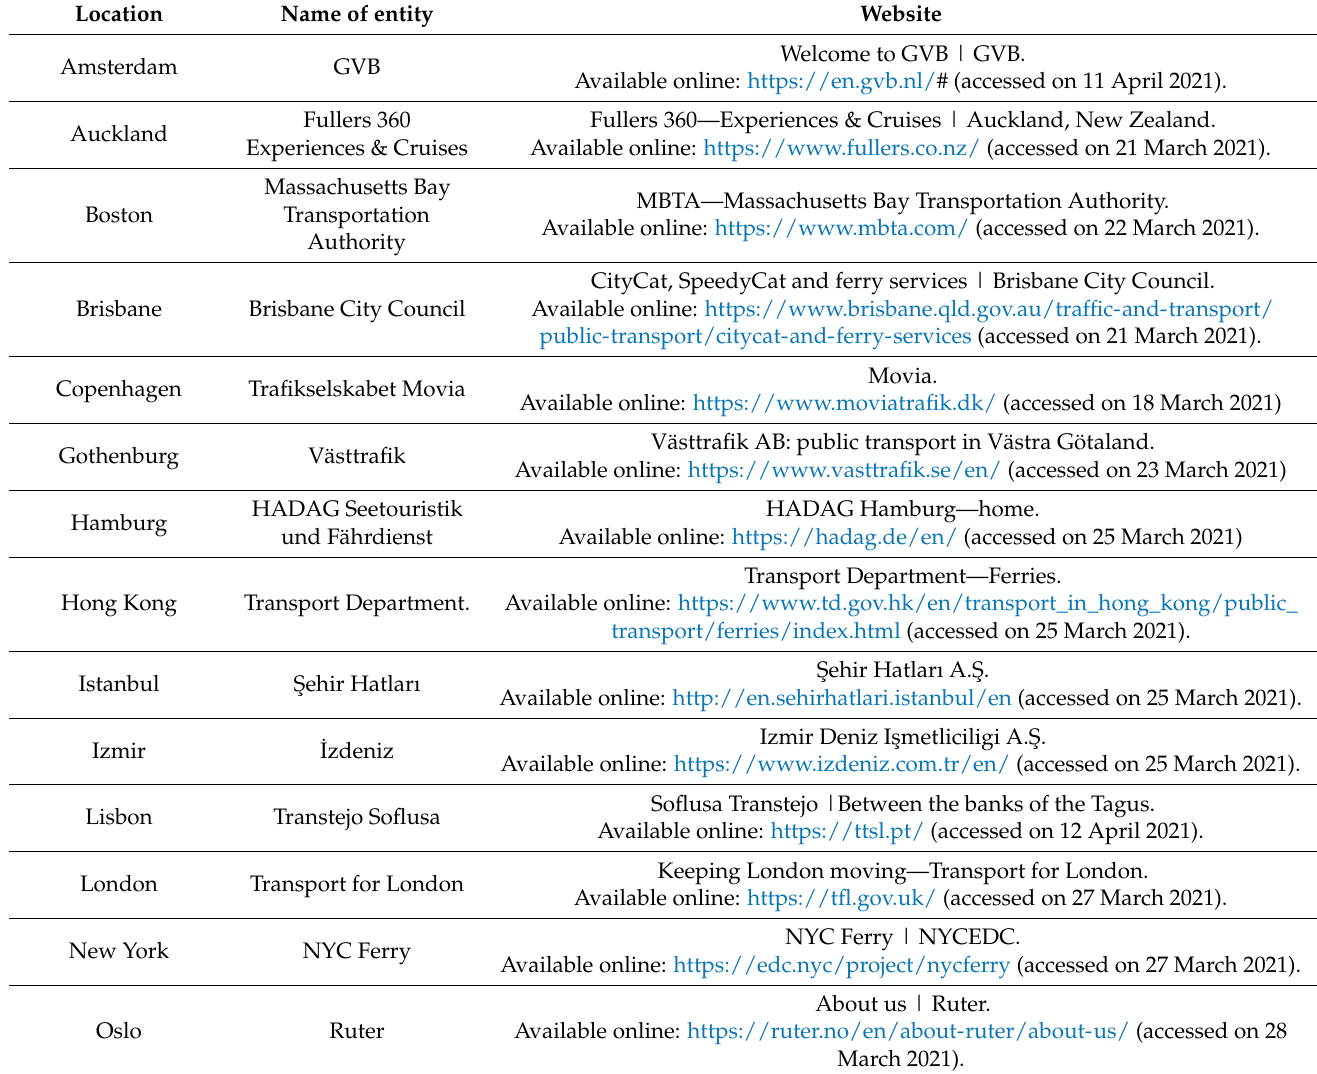
Table A1. The list of core actors responsible for the shift towards